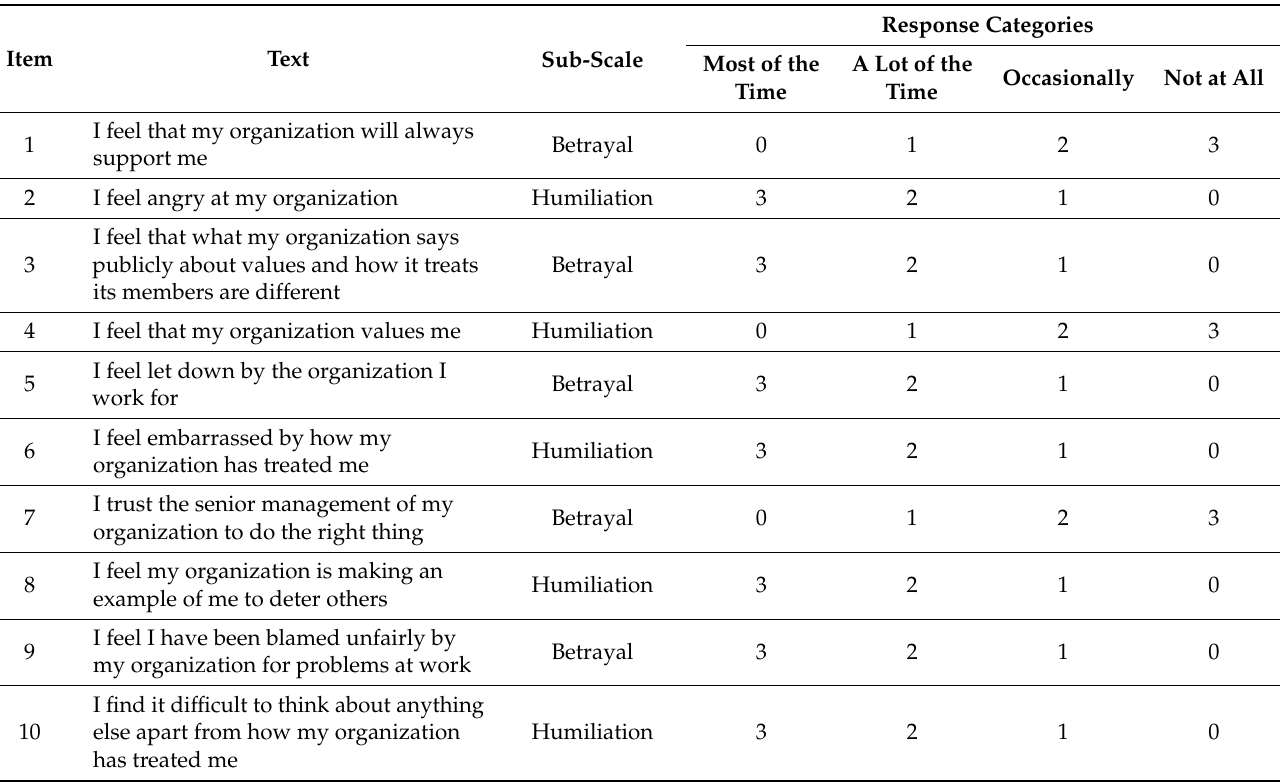
Table 2. WAS items and